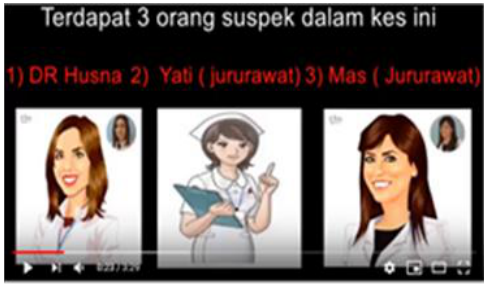
Figure 7: A doctor cheating